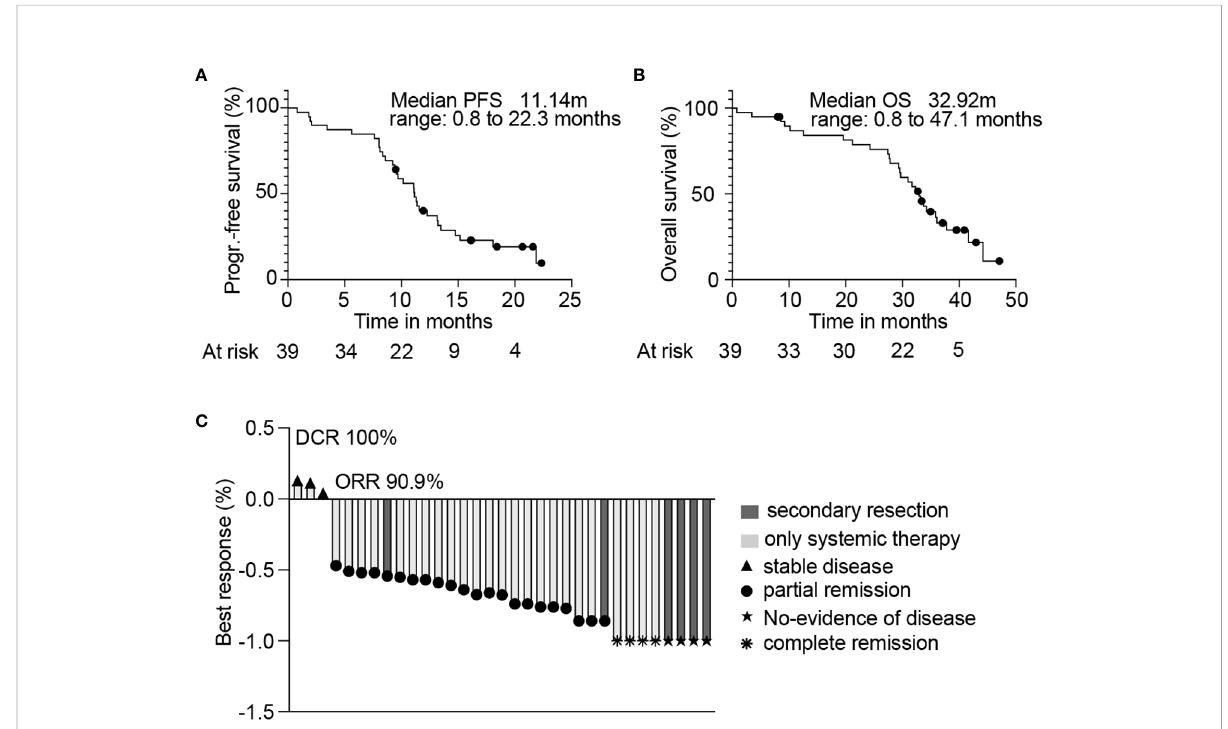
FIGURE 1 Kaplan-Meier estimates of 39 patients from the AVETUX trial for PFS (A) and OS (B) . Number of patients at speci fi c timepoints are indicated. Median PFS or OS is depicted. (C) Best response achieved and con fi rmed in radiological review is presented. Secondary resection, chemotherapy only, stable disease, partial remission, no evidence of disease (after resection) or complete remission is